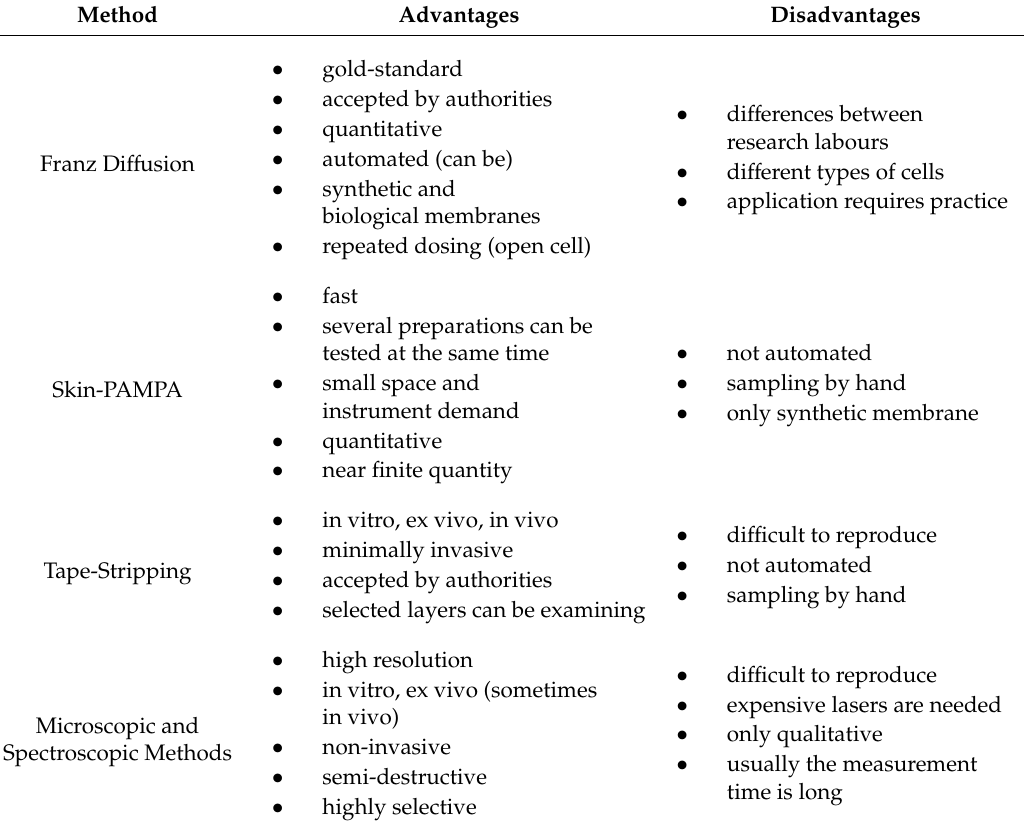
Table 7. Advantages and disadvantages of previously discussed